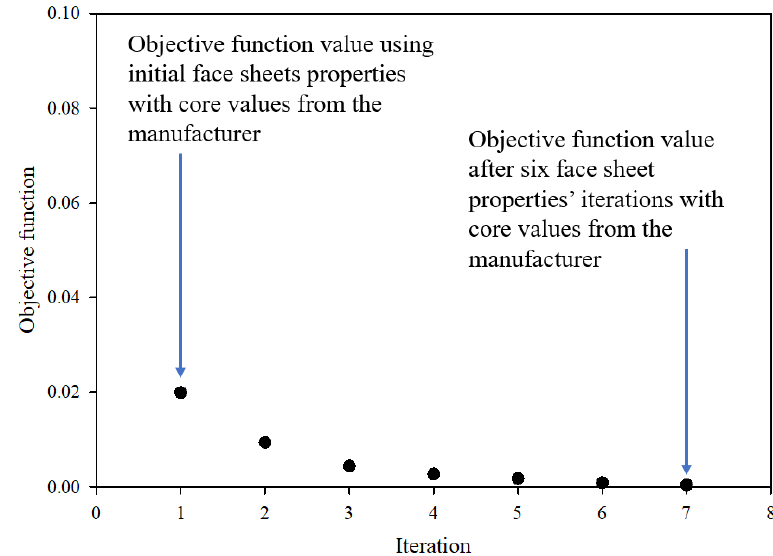
Figure 3. Objective function value as a function of properties iterations.